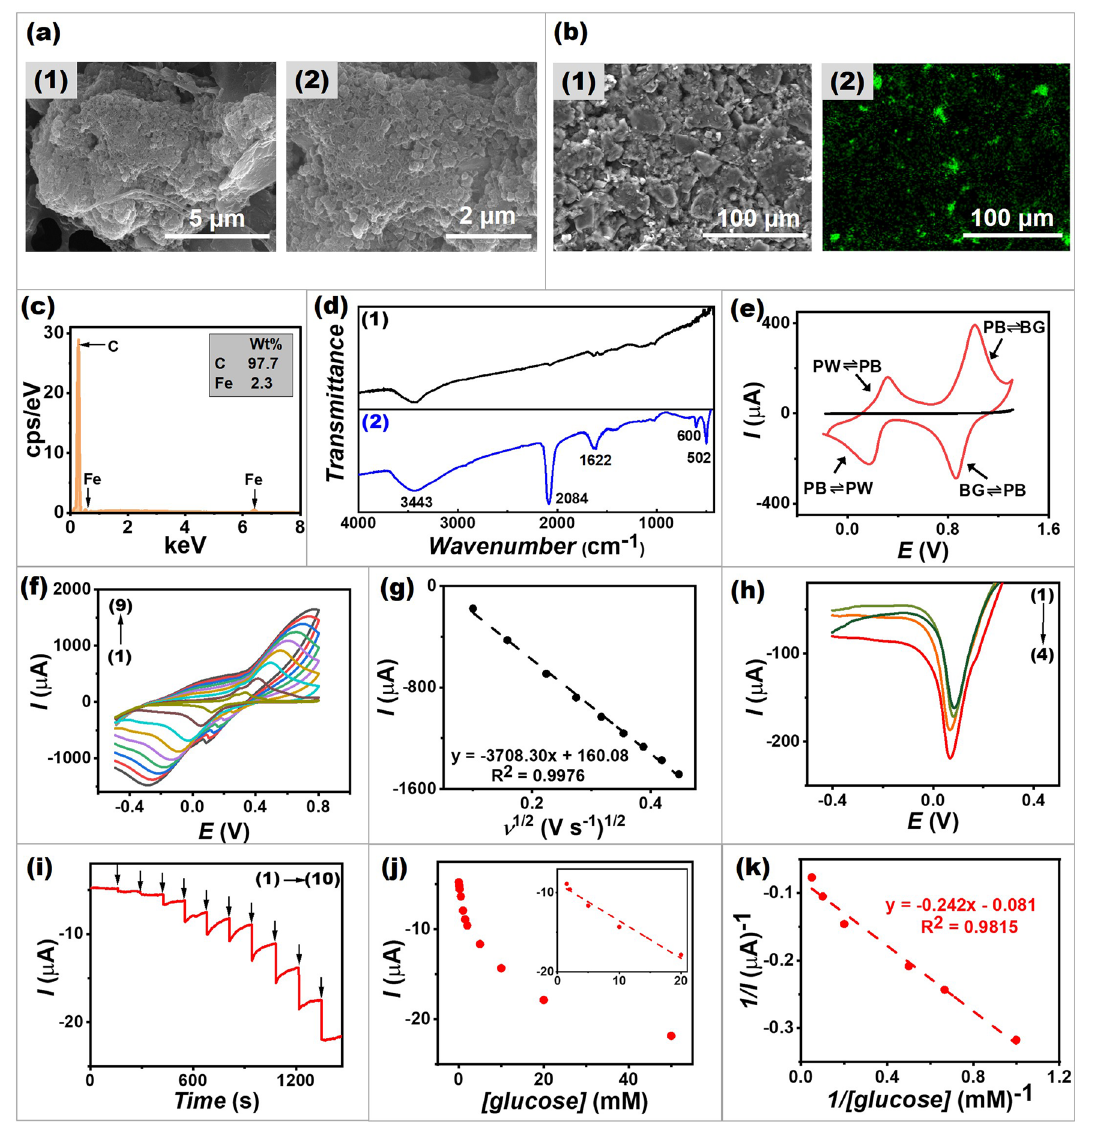
Fig. 3 Characterizations of the cathode. a SEM images of a screen-printed PB/MWCNT-based cathode at (1) low magnification and (2) high magnification. b SEM image (1) with EDX mapping for (2) Fe elements in PB/MWCNT-based cathode. c EDX spectra of PB/MWCNT-based cathode. d FT-IR spectra of (1) MWCNT and (2) synthesized PB/MWCNT. e CVs obtained from (black line) the glassy carbon (GC) electrode and (red line) the PB/MWCNT-coated GC electrode in 0.1 M PBS, pH 7.0 with a scan rate of 50 mV s −1 . f CVs obtained from a screen-printed PB/MWCNT-based cathode in 0.1 M PBS, pH 7.0 at different scan rates from 10 to 200 mV s −1 (scan rates (1–9): 10, 25, 50, 75, 100, 125, 150, 175 and 200 mV s −1 ). g Plots of cathodic peak current densities in function with square root of the scan rate obtained on a screen-printed PB/ MWCNT-based cathode. h LSVs obtained from a screen-printed PB/MWCNT-based cathode in the presence of H 2 O 2 ((1) blank; (2) 0.5 mM; (3) 2 mM; and (4) 5 mM) in 0.1 M PBS, pH 7.0 with a scan rate of 5 mV s −1 . i Amperometric response of a screen-printed GOx/PB/MWCNT- based biocathode with an applied potential of 0 V versus Ag/AgCl upon increasing the glucose concentrations ((1) 0.1 mM; (2) 0.2 mM; (3) 0.5 mM; (4) 1 mM; (5) 1.5 mM; (6) 2 mM; (7) 5 mM; (8) 10 mM; (9) 20 mM; and (10) 50 mM). j The corresponding calibration plot of the current response of the GOx/PB/MWCNT-based biocathode. k The double reciprocal plot of the calibration curve obtained from the GOx/PB/ MWCNT-based biocathode. (Color figure